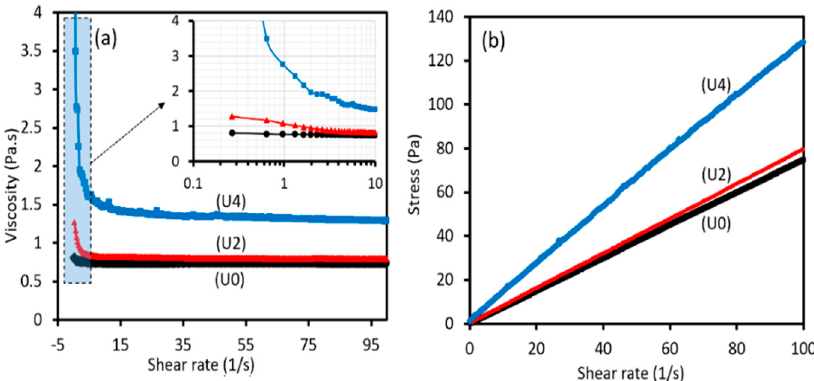
Figure 2. Viscosity-shear rate curves ( a ), and stress-shear rate curves ( b ) for various coal tar pitch/ polyacrylonitrile (CTP/PAN) solutions. Table 1. Rheological and structural properties of PAN/CTP solutions.